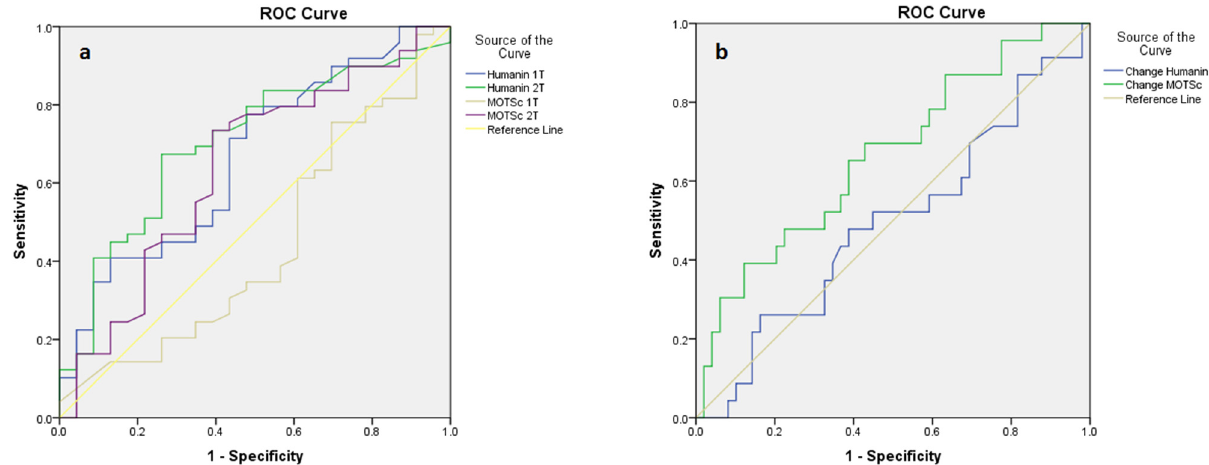
Figure 2. Receiver operating characteristic (ROC) curve for high HOMA-IR in relation to mitochondria-derived peptides in the first trimester (1T) and second trimester (2T) separately ( a ) and in relation to sample-related changes for each peptide throughout pregnancy ( b ). ( a ) High HOMA-IR was defined as a value ≥ 70th percentile ( ≥ 1.90 1T and ≥ 2.28 2T); Humanin 1T: AUC 0.698 (95% CI 0.569–0.826); Humanin 2T: AUC 0.705 (95% CI 0.578–0.831); MOTSc 1T: AUC 0.497 (95% CI 0.355–0.638); MOTSc 2T. AUC: 0.640 (95% CI 0.498–0.782). ( b ) High HOMA-IR was defined as a value ≥ 70th per-